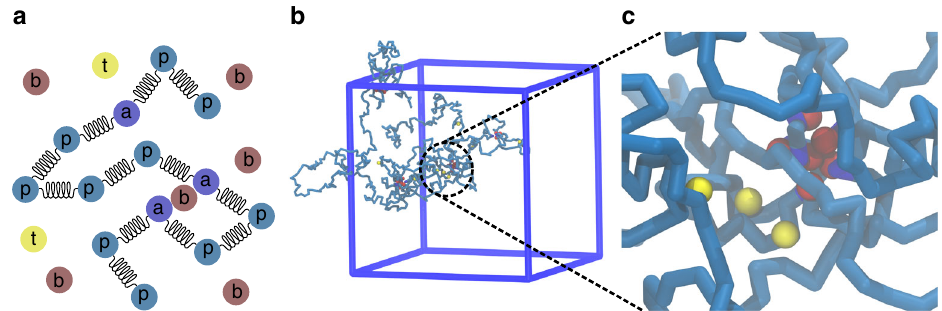
Fig. 1 Description of the simulation setup. a The polymer is made of p (polymer) and a (anchor) particles, connected by harmonic springs. Binders (b particles) are introduced to bridge a particles. Tracers (t particles) interact non-speci fi cally with both p and a particles. Binders and tracers interact only by hard-core repulsion, i.e., by volume exclusion. b Snapshot of a simulation together with the simulation box. c Zoom-in of a loop formed by the binders and their binding sites, along with the tracers bound